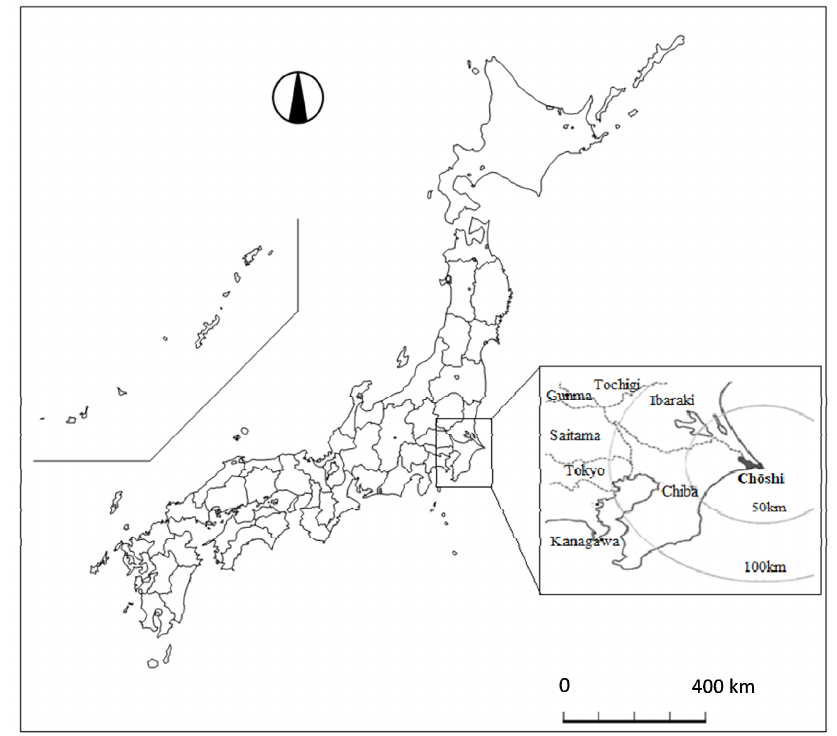
Figure 1. Map of Tokyo metropolitan area and Ch ō shi City in Japan.